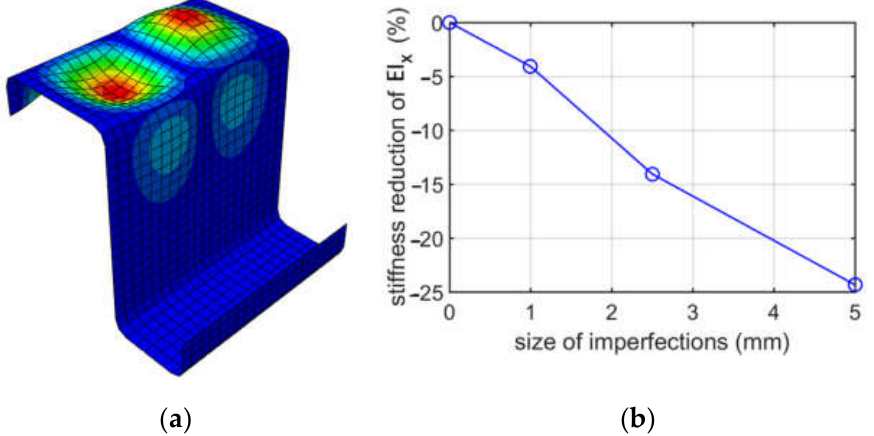
Figure 8. Buckling due to bending about the vertical axis for case (ii) (tension of the lower part of the cross-section), for a depth of 100 mm: ( a ) mode 1; ( b ) plot of the stiffness reduction of EI x , depending on the size of imperfections.